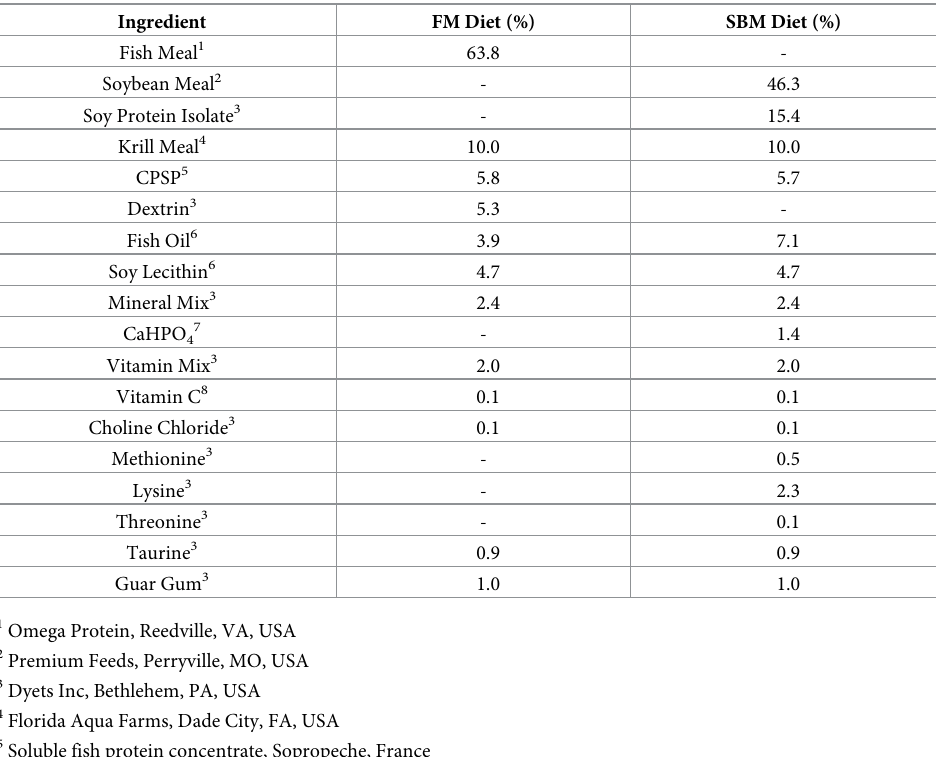
Table 1. Feed formulation (g/100g) of experimental